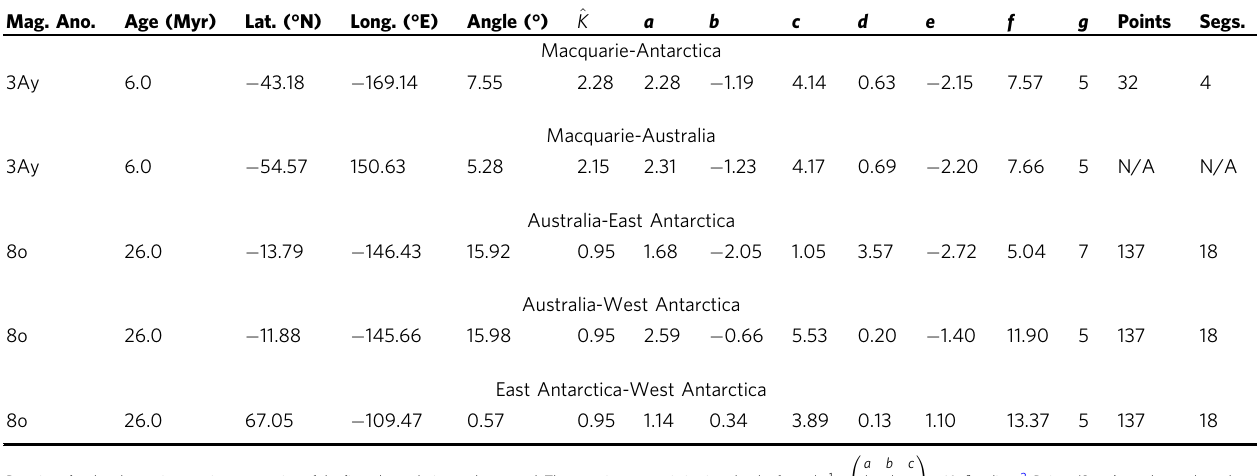
Table 1 Finite rotations and their covariance matrices Mag.